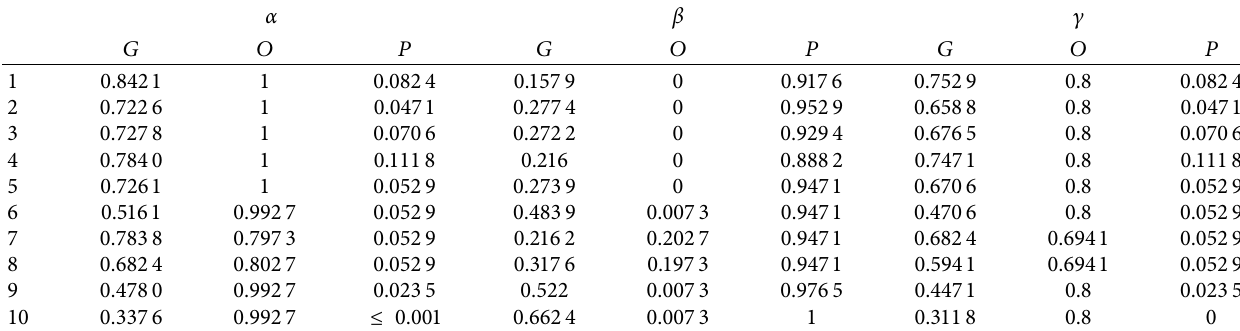
Table 5: Uncertainty measurement on “own-data 1.”